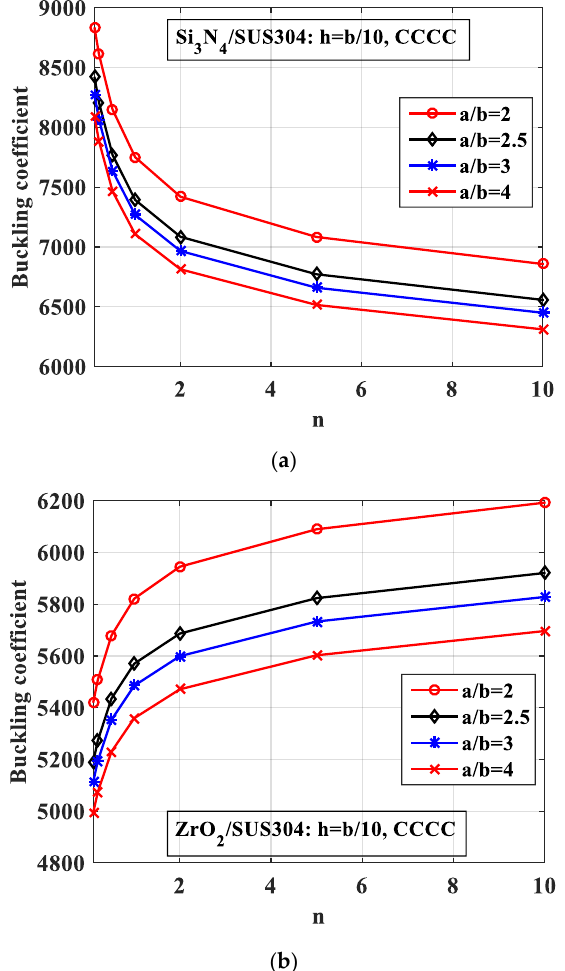
Figure 8. Variation of the buckling coefficient of the plate by the variation of the length-to-width ratio ( a / b ). ( a ) Si 3 N 4 /SUS304; ( b ) ZrO 2 /SUS304.